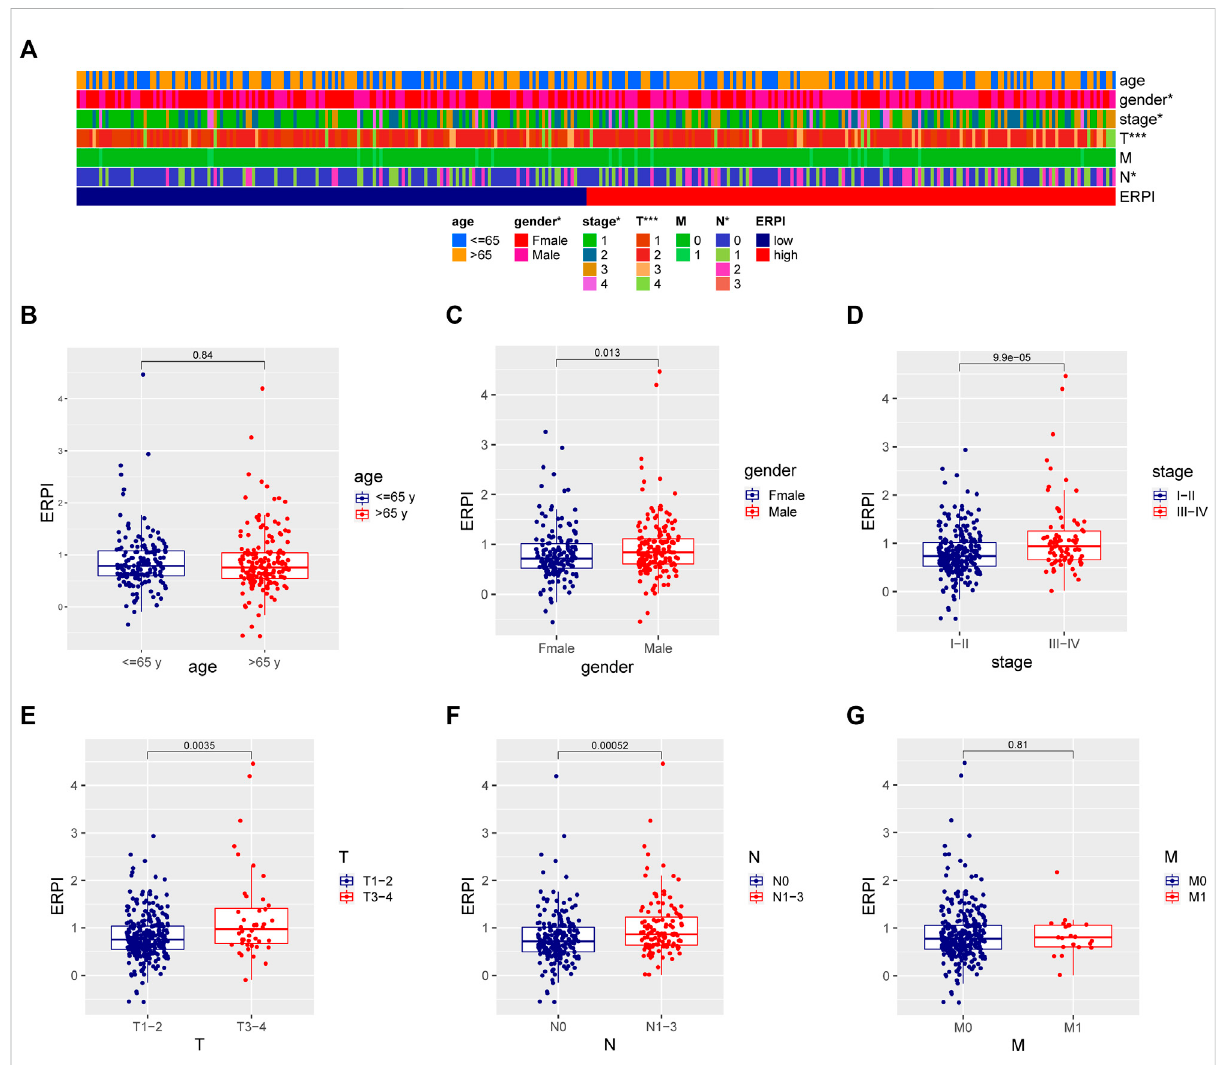
FIGURE 6 Relationship between ERPI and clinicopathological variables. (A) Clinicopathological variables between the high- and low-ERPI groups. (B – G) ERPI between subgroups divided by clinicopathological